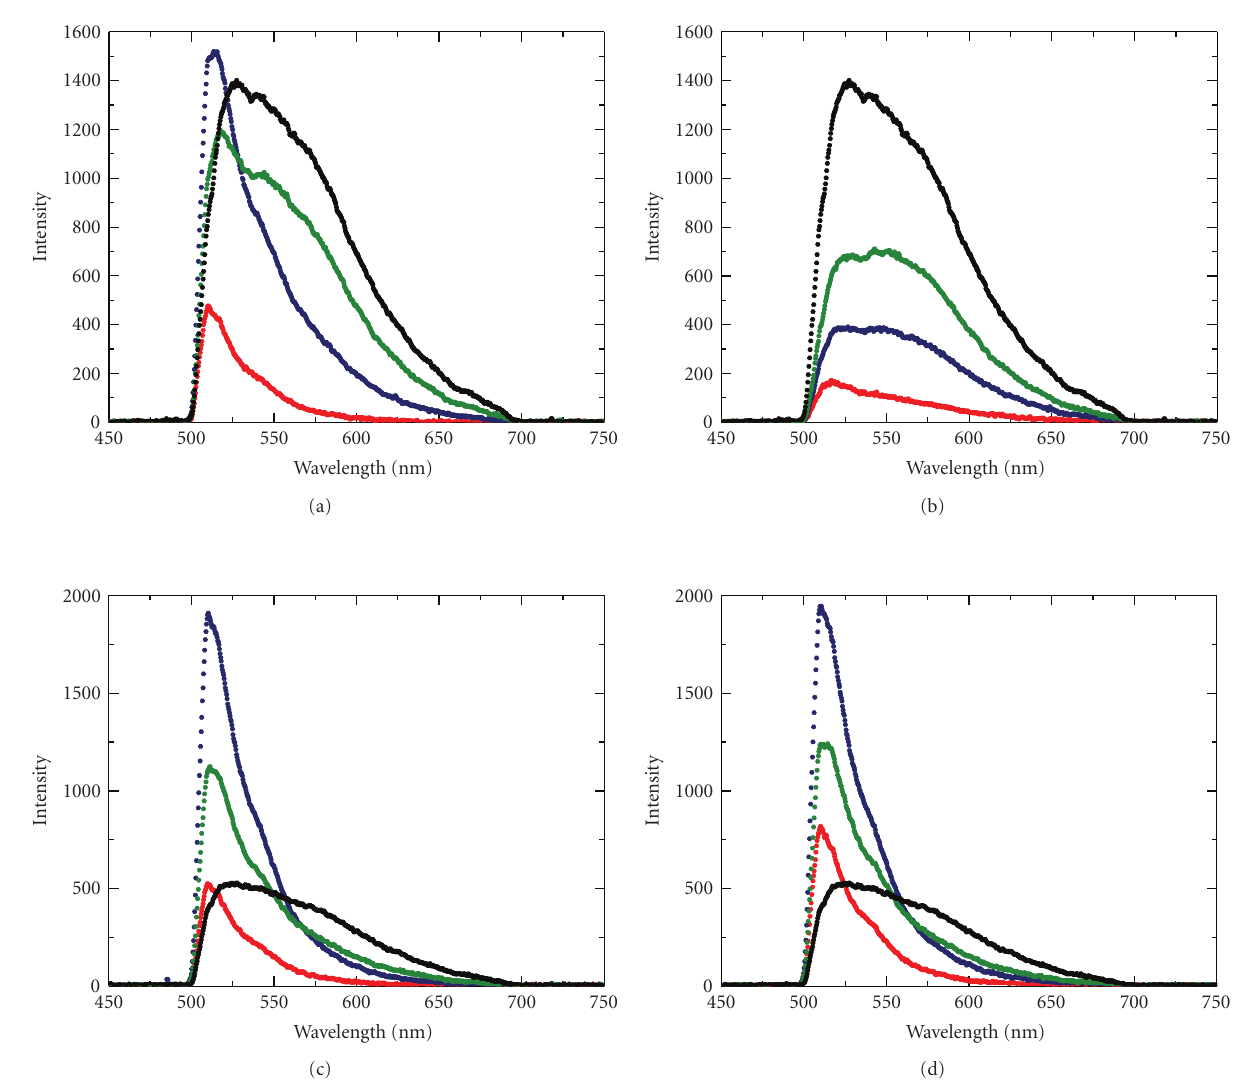
Figure 2: Fluorescence spectra of binary-constituent lipid monolayers containing BODIPY-labeled phosphatidylcholine. Fluorescence emission intensity of BODIPY-labeled PC is plotted against emission wavelength. (a) Me 4 BODIPY-PC/POPC monolayers at 30 mN/m lateral pressure; (b) Me 4 BODIPY-PC/DPPC monolayers at 30 mN/m, (c) Me 4 BODIPY-PC/POPC monolayers at 5mN/m, (d) Me 4 BODIPY-PC- /DPPC monolayers at 5mN/m. Color codes: 1% Me 4 BODIPY-PC (red), 10% Me 4 BODIPY-PC (blue), 20% Me 4 BODIPY-PC (green), 100% Me 4 BODIPY-PC